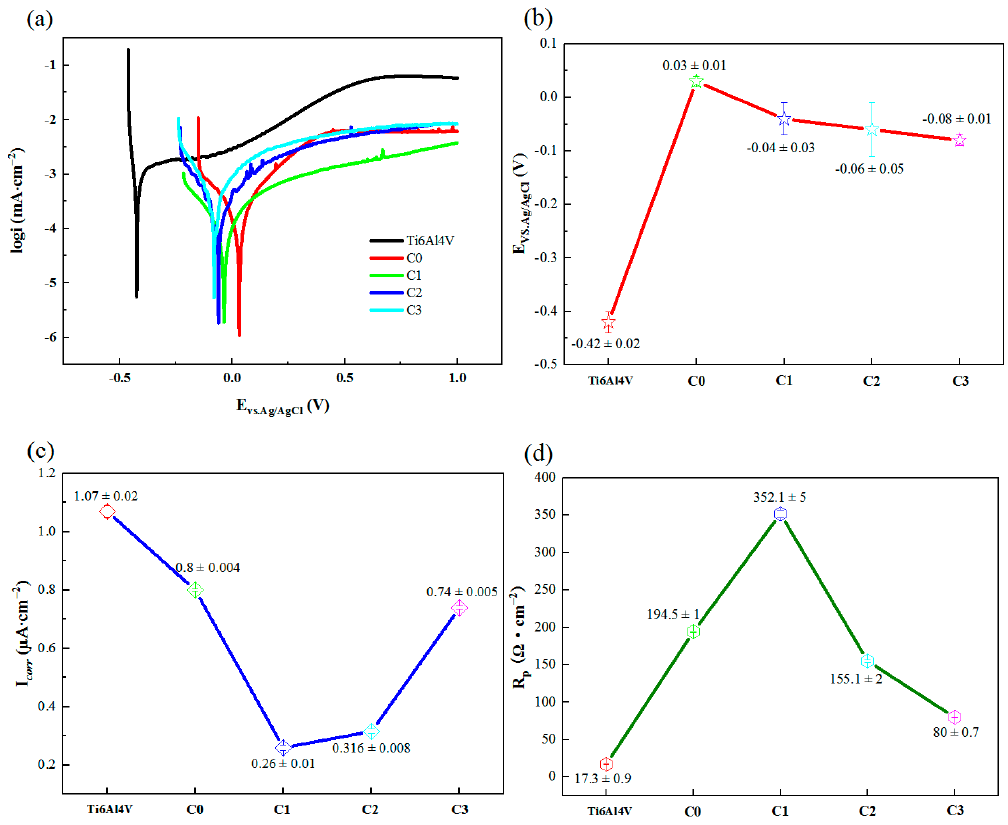
Figure 10. Potentiodynamic polarization curves ( a ) and corrosion parameters of coated and uncoated Ti6Al4V: ( b ) E corr , ( c ) I corr , ( d ) R p .